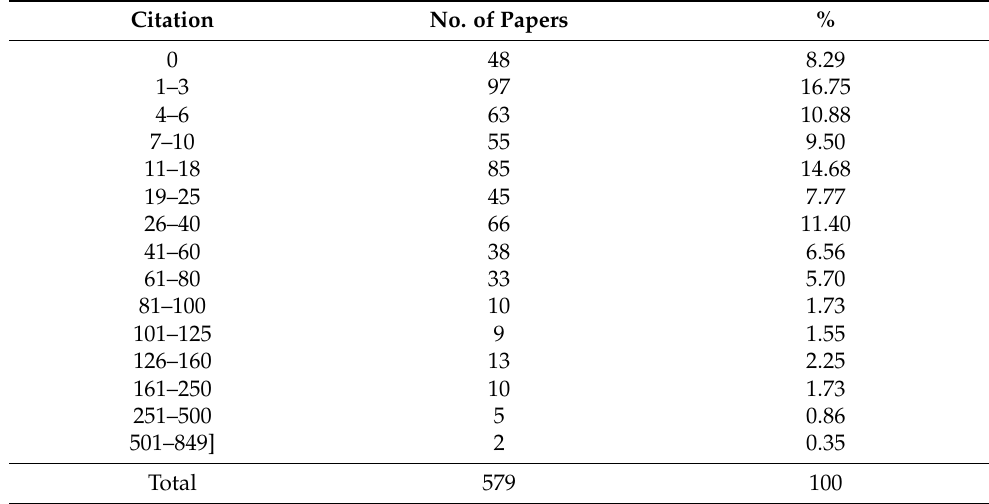
Table 20. Number of citations per paper (data analyzed by consulting the database on 15 March